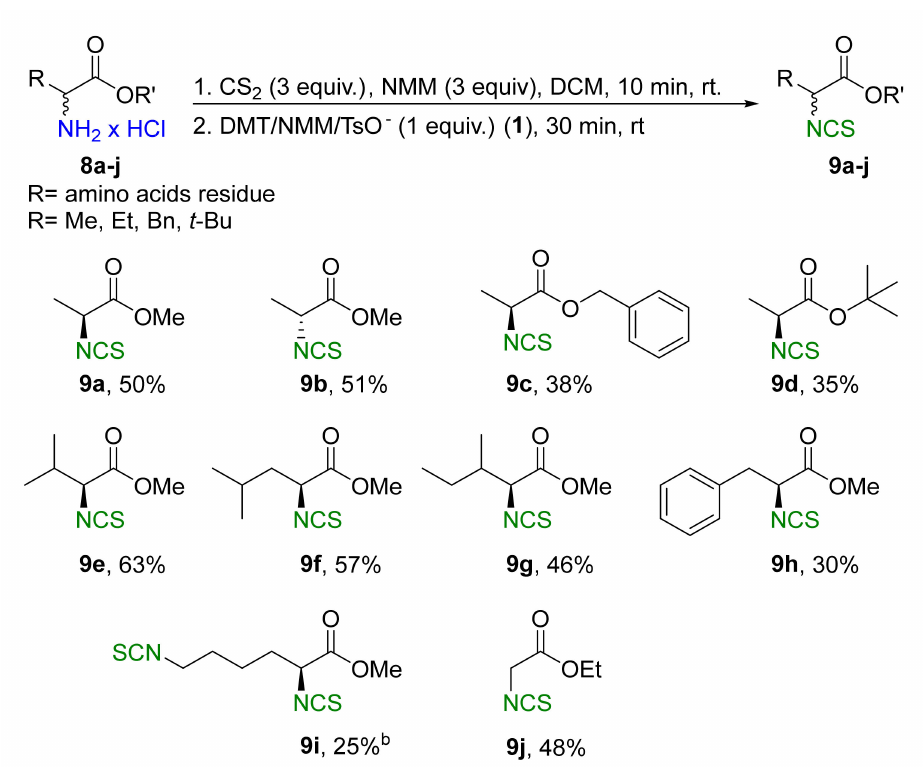
Figure 5. Scope of isothiocyanate derivatives of amino acids 9a – j a . a -conditions: hydrochloride 8a – j (2 mmol), NMM (0.66 mL, 3 equiv., 6 mmol), CS 2 (0.36 mL, 3 equiv., 6 mmol), DCM (5 mL); first step 10 min, rt, then DMT/NMM/TsO − ( 1 ) (0.828 g, 1 equiv., 2 mmol,), normal conditions, rt., 30 min. Products isolated after flash chromatography (hexane:EtOAc 20:1); b –conditions: hydrochloride 8i (2 mmol), NMM (1.32 mL, 6 equiv., 12 mmol), CS 2 (0.72 mL, 6 equiv., 12 mmol), DCM (5 mL); first step 10 min, rt, then DMT/NMM/TsO − ( 1 ) (1.656 g, 2 equiv., 4 mmol,), normal conditions, rt., 30 min. Products isolated after flash chromatography (hexane:EtOAc 20:1).